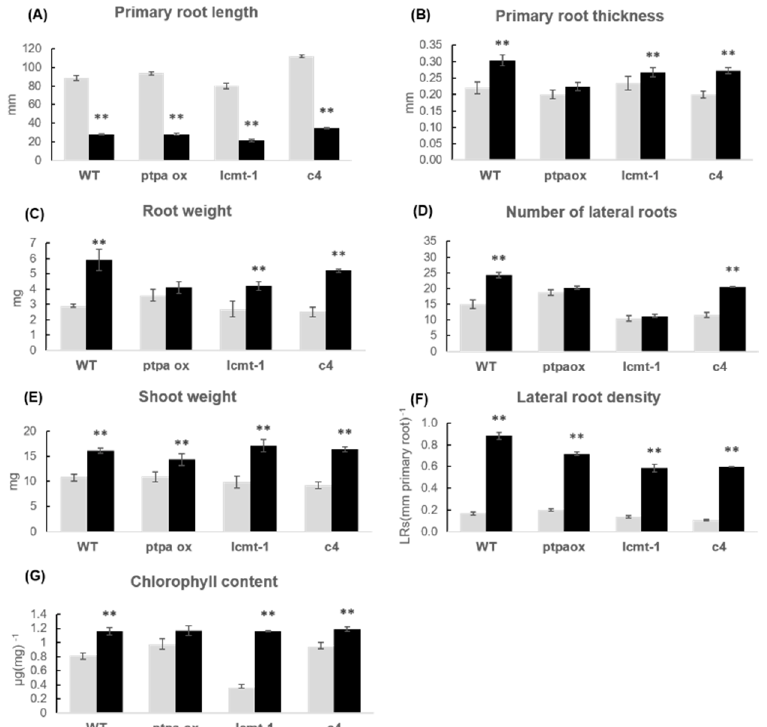
Figure 4. Growth parameters of WT and mutants treated with P. simiae WCS417r. Seedlings of Arabidopsis WT, ptpaox , lcmt1 , and c4 were cultivated without (grey bars) and with (black bars) P. simiae WCS417r for two weeks. ( A ) primary root length; ( B ) primary root thickness; ( C ) root fresh weight; ( D ) number of lateral roots; ( E ) shoot fresh weight; ( F ) lateral root density; and ( G ) chlorophyll content. For root length, primary root thickness, number of lateral roots, and root density, data are means ± SE of 30 plants ( n = 30). For fresh weight and chlorophyll content, the plants in each plate were pooled for measurements, and data given is the average of six independent experiments, n = 6, ±SE is given. The root and shoot weights ( C , E ) represent single plant averages. The chlorophyll values ( G ) represent µg chlorophyll per mg leaf tissue. According to Student’s t -test and p -value < 0.05, columns marked with two asterisks are significantly different from the control without bacteria.